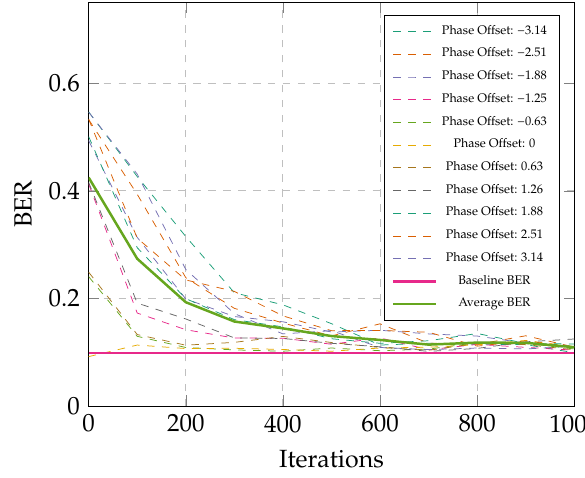
Figure 10. Convergence of phase offset for E b / N 0 = 2.